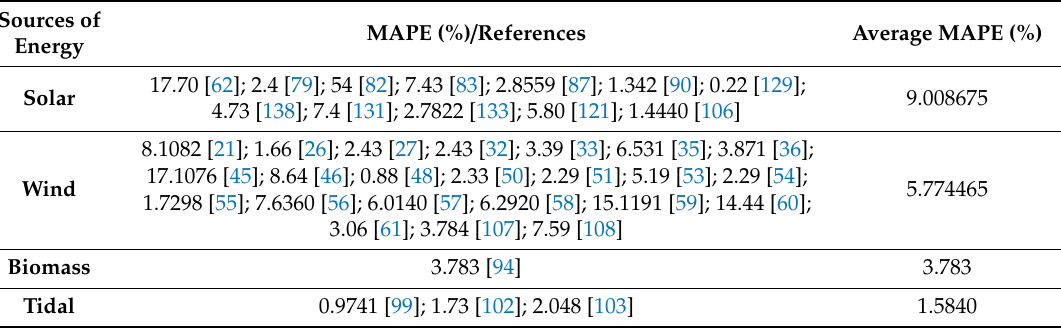
Table 7. MAPE values in energy prediction literature.